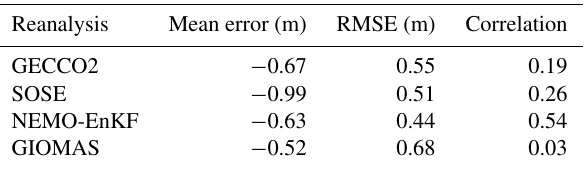
Table 3. The mean ice thickness bias, root mean square error esti- mate and correlation between ICESat-1 and the four sea-ice thick- ness